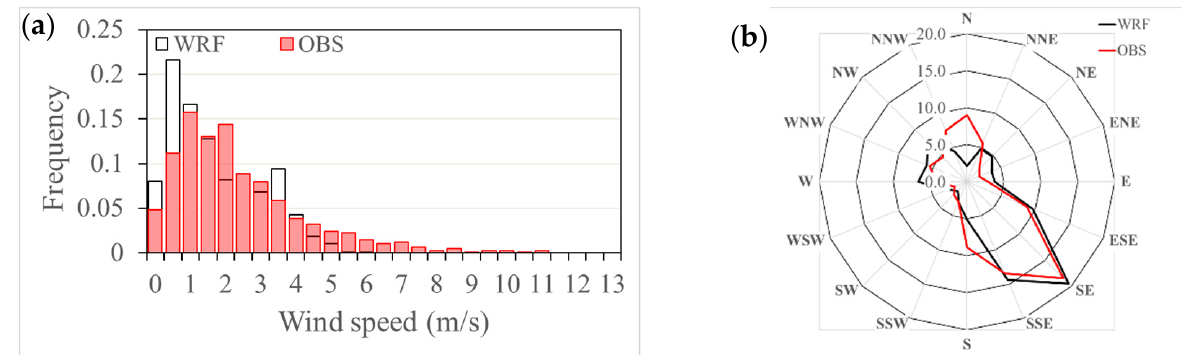
Figure 6. Validation for wind conditions. ( a ) Frequency distribution of wind speed in August 2002; ( b ) frequency distribution of wind direction in August 2002.